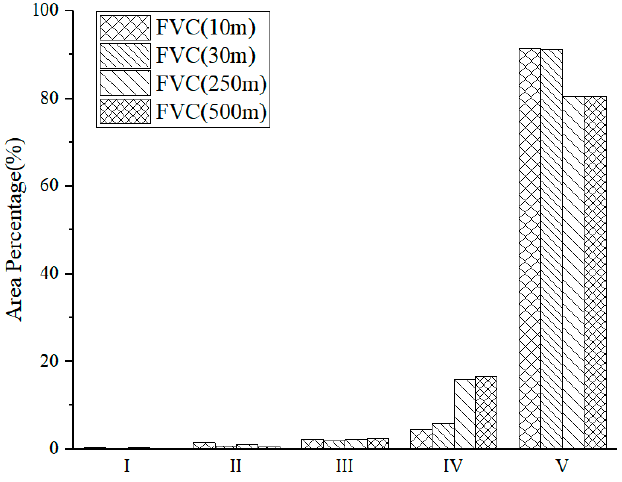
Figure 5. The areal proportions of FVC levels (I to V) derived using image data of different spatial resolutions. See Table 2 for a definition of the coverage levels.